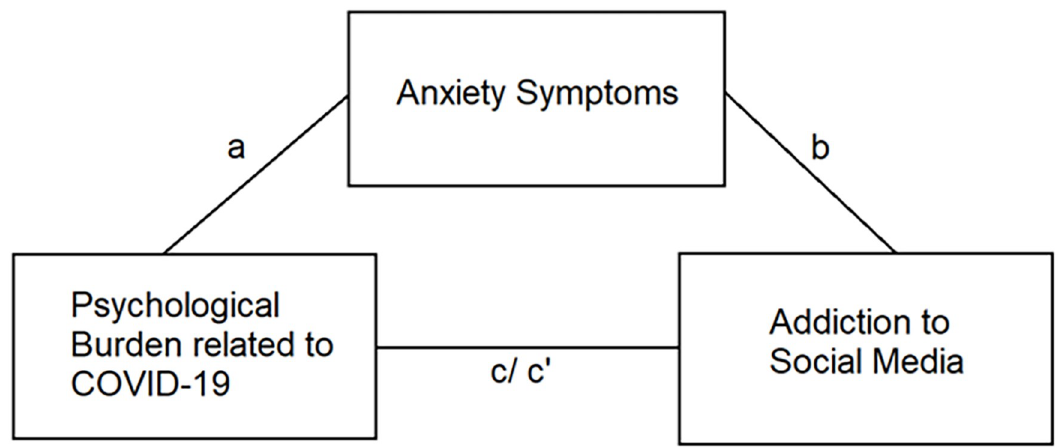
Fig 1. Proposed mediation model consisting of psychological burden related to COVID-19 as the predictor, anxiety as the proposed mediator, and social media addiction as the outcome. a = path of predictor to mediator; b = path of mediator to outcome; c = path of predictor to outcome without mediator; c’ = path of predictor to outcome with inclusion of the